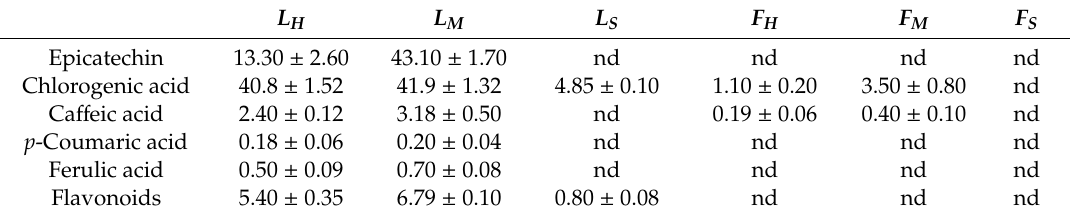
Table 5. HPLC-DAD quantitative analysis, expressed in mg / g of dry extract. L